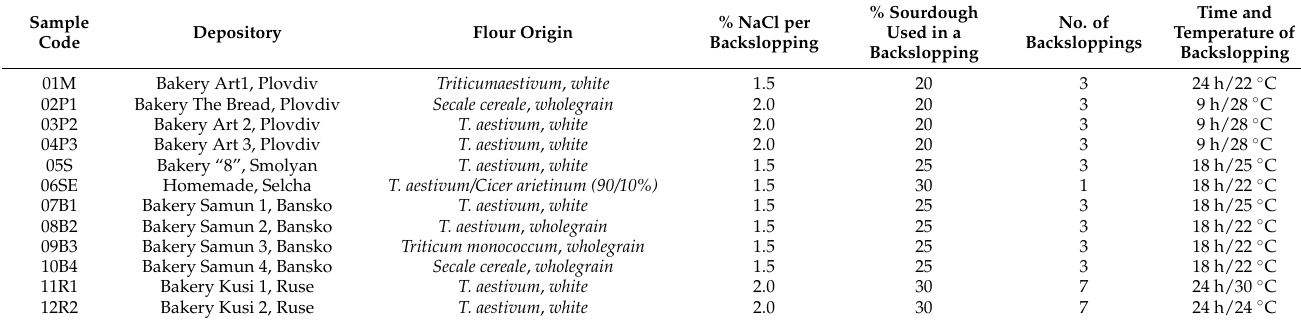
Table 1. Ingredients and preparation methods of Bulgarian sourdoughs (no baker’s yeast used). Sample